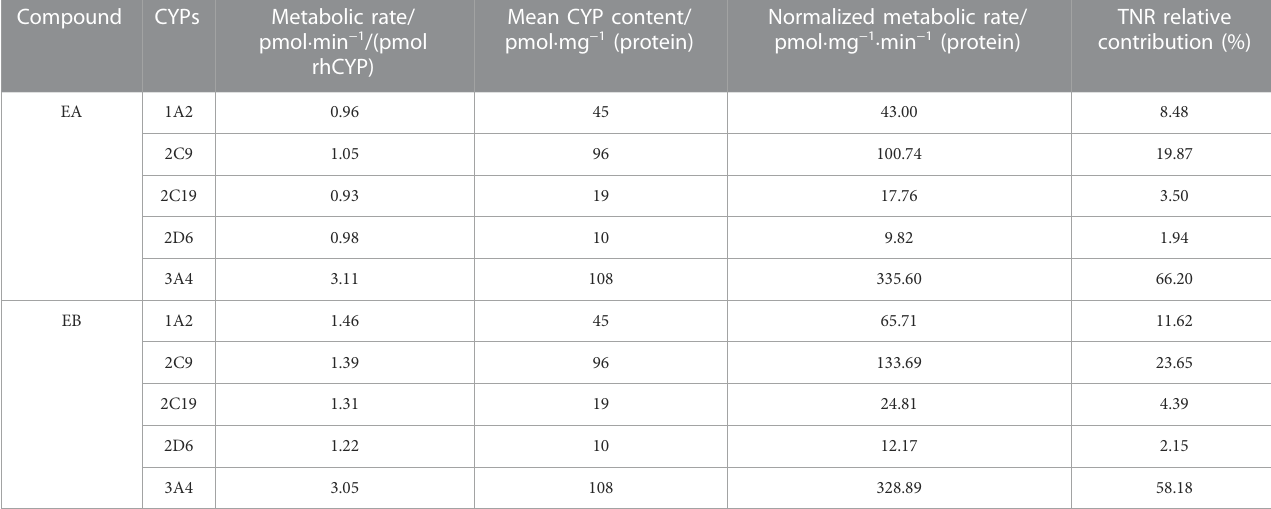
TABLE 5 Contributions of rhCYPs to EA or EB metabolism assessed by the TNR approach ( n = 3).